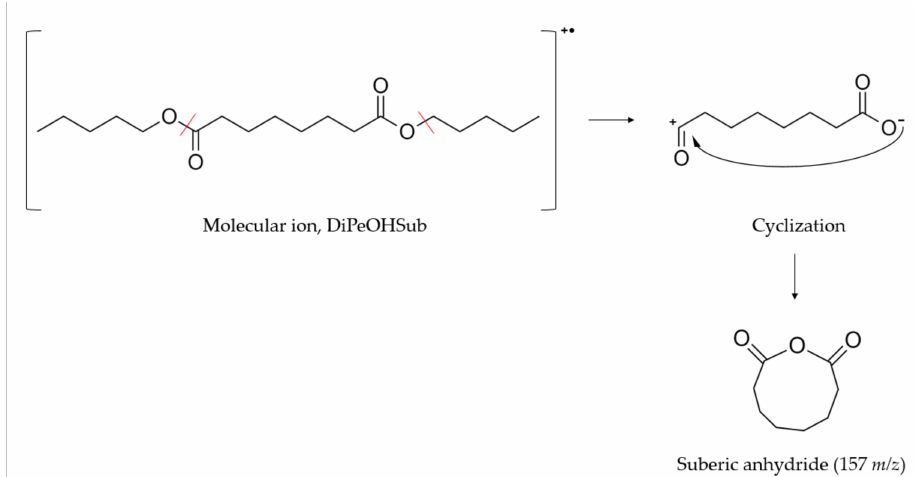
Figure 2. Proposed fragmentation and consecutive cyclization of diesters derived from 1-pentanol and 1-decanol. A cleavage of the alcohol on one side and the alkyl carbon chain on the other side occurs, followed by a closed ring formation. In the example, the mechanism for the formation of suberic anhydride from DiPeOHSub is reported, the peak of which appears at 157 m / z with 71% relative